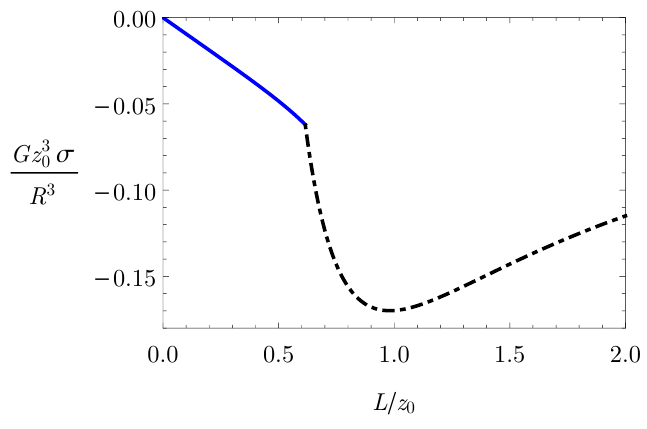
), versus L=z 0 for the AdS soliton with d = 4. 0